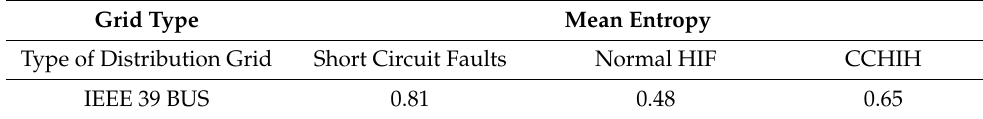
( b ) Figure 16. ( a ) Polar representation of extracted features of HIF fault ( b ) Polar representation of ex- tracted features of CCHIF fault. 6.4. The Effect Brought by the Changing of the Reactor String In this section, the suggested fault diagnosis strategy is put through its paces under a variety of operating and switching conditions. This is accomplished through the switch- ing function of reactor strings, such as line reactors. In IEEE 39 bus system, 50 MVA reac- tor strings were connected and CCHIF has created to determine the fault feature. In Figure 12 distorted voltage signal and extracted features are shown. Figure 17, which shows the frequency response of the TQWT band-pass filter, shows that three decomposition layers make the most sense. The factor redundancy r is the total number of wavelet factors divided by the length of the signal that the TQWT is used on [37]. As there are 6144 coefficients here and 2048 samples, r = 3. The Q-factor has something to do with how wide the bandpass filter is. The bandpass filter is very wide for having a low Q-factor, and it only needs a few levels to